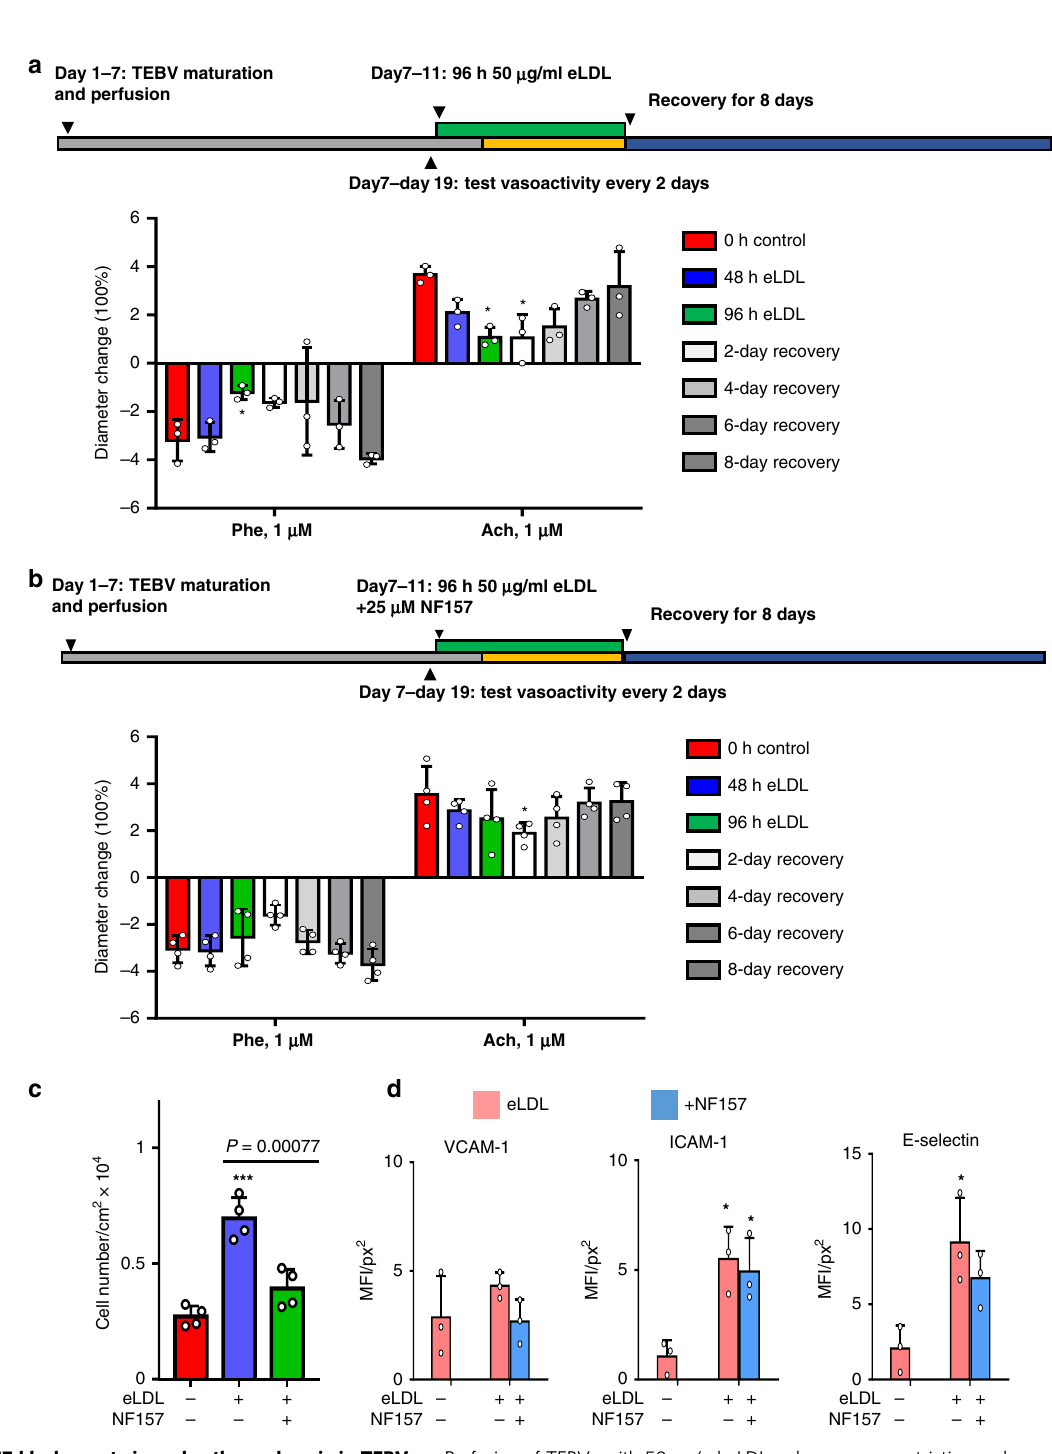
Fig. 9 NF157 block events in early atherosclerosis in TEBVs. a Perfusion of TEBVs with 50 μ g/ml eLDL reduces vasoconstriction and vasodilation, but the response recovers 8 days after removal of eLDL (mean±S.D., n = 4 TEBVs, *PE: P = 0.01408, Ach: * P = 0.01543 to control by two-way ANOVA and Tukey post hoc test). b Addition of 25 µ M NF157 with 50 µ g/ml reduces the inhibition of vasoactivity and leads to a more rapid recovery after removal of eLDL (mean±S.D., n = 4 TEBVs, * P = 0.01369 to control by two-way ANOVA and Tukey post hoc test). c NF157 block eLDL-mediated monocyte accumulation in TEBVs (mean±S. D., n = 4 TEBVs, * P <0.05, ***P<0.0001 to control by two-way ANOVA). d NF157 does not inhibit ICAM-1 and E-selectin expression on endothelial cells in TEBVs (mean±S.D., n = 3 TEBVs, ICAM-1: * P = 0.0136 control vs. eLDL, * P = 0.0252 control vs. eLDL + NF157; E-selectin * P = 0.0181 control vs. eLDL by two- way ANOVA and Tukey post hoc test, MFI = mean fl uorescence intensity; Flow rate: 0.4Pa to vasoactivity testing and 0.1Pa for monocyte and Hoechst dye (1:1000) to stain nuclei. Images were acquired using a Leica SP5 inverted confocal microscope (software “ LAS AF v2.7.3.9723 ” ). Oil Red staining was performed by using standard protocols on vessels fi xed in 4% paraf- the primary antibodies were treated with fl uorescently labeled secondary anti- ormaldehyde. The images were acquired using a fl uorescence microscope (Nikon bodies: 488-goat anti mouse IgG, 488-goat anti rabbit IgG, 546-goat anti mouse model TE2000-U, software “ NIS-Elementa AR v3.2 ” ). IgG, 546-goat anti rabbit IgG, 633-goat anti mouse (1:200) (Life Technologies)